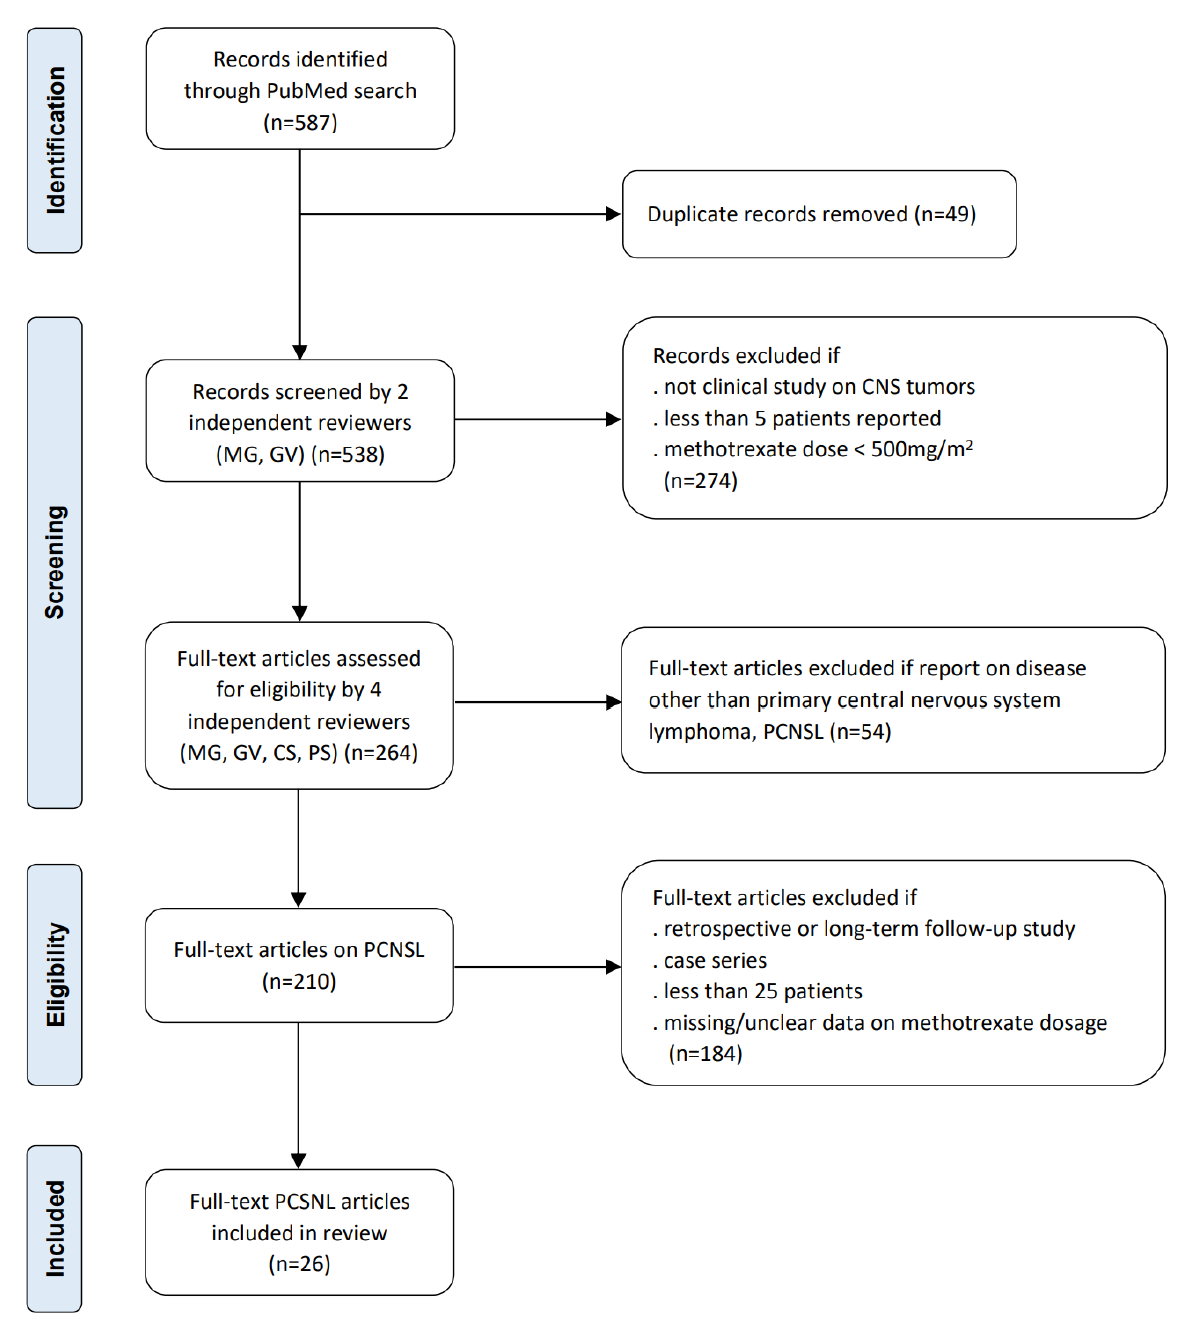
Figure 1. Flow diagram of systematic review according to PRISMA guidelines.